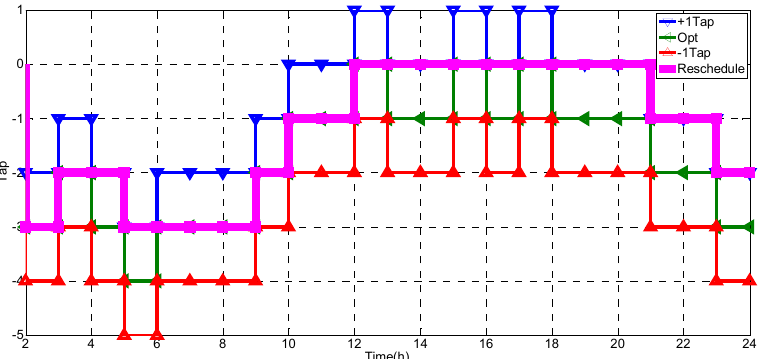
Figure 25. Schedule adjustment by the proposed scheme of case 1 for CVR.